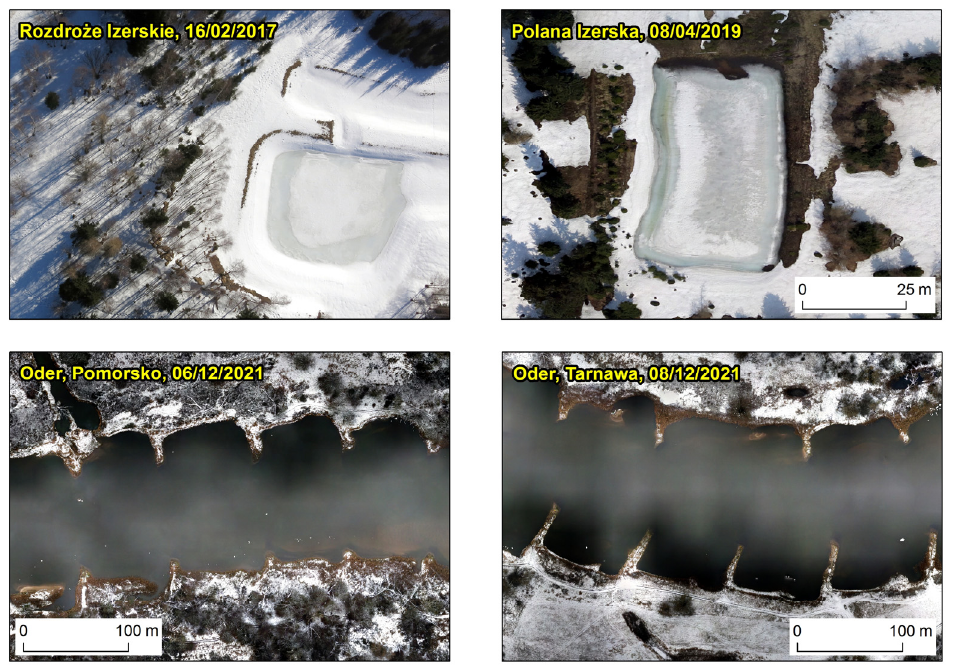
Figure 21. Fragment of single aerial image taken in central projection by a UAV over Rozdro ż e Izerskie in southwest Poland showing two interconnected frozen reservoirs ( top left ), fragment of the SfM-based orthophotomap of Polana Izerska in southwest Poland centered on a frozen reservoir ( top right ), fragments of the SfM-based orthophotomaps of the Oder River in west Poland in Pomorsko ( bottom left ) and Tarnawa ( bottom right ) showing an unfrozen river channel (source: Department of Geoinformatics and Cartography, University of Wroc ł aw).